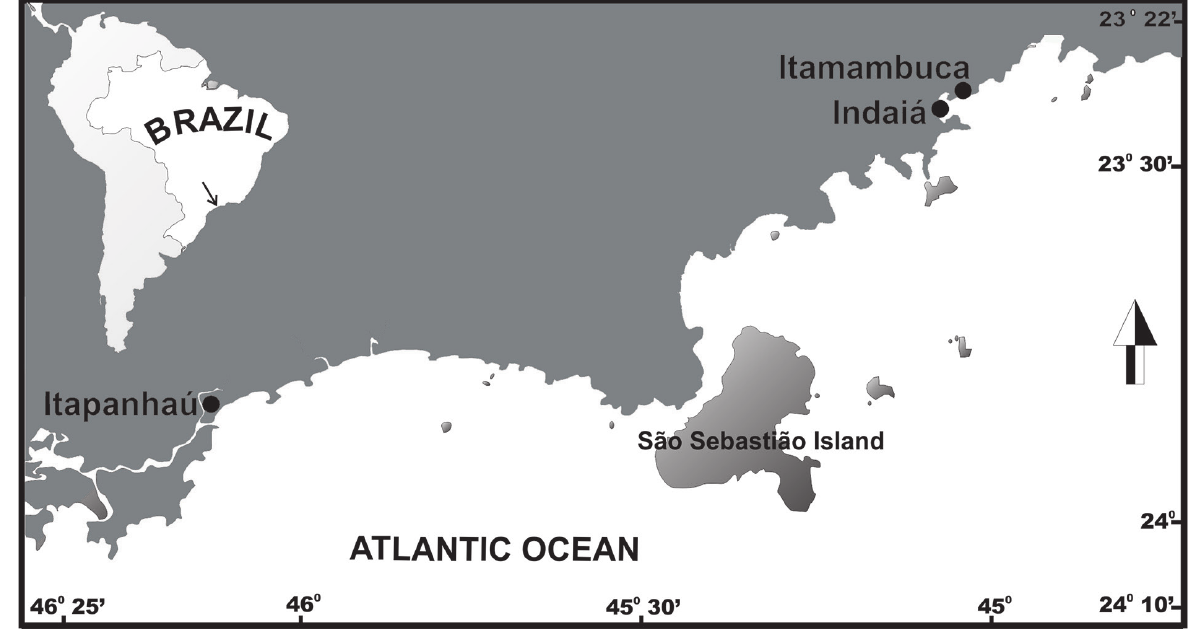
Figure 1. Locations of the three mangroves studied at latitude 23° S, of the subtropical Brazilian coast (São